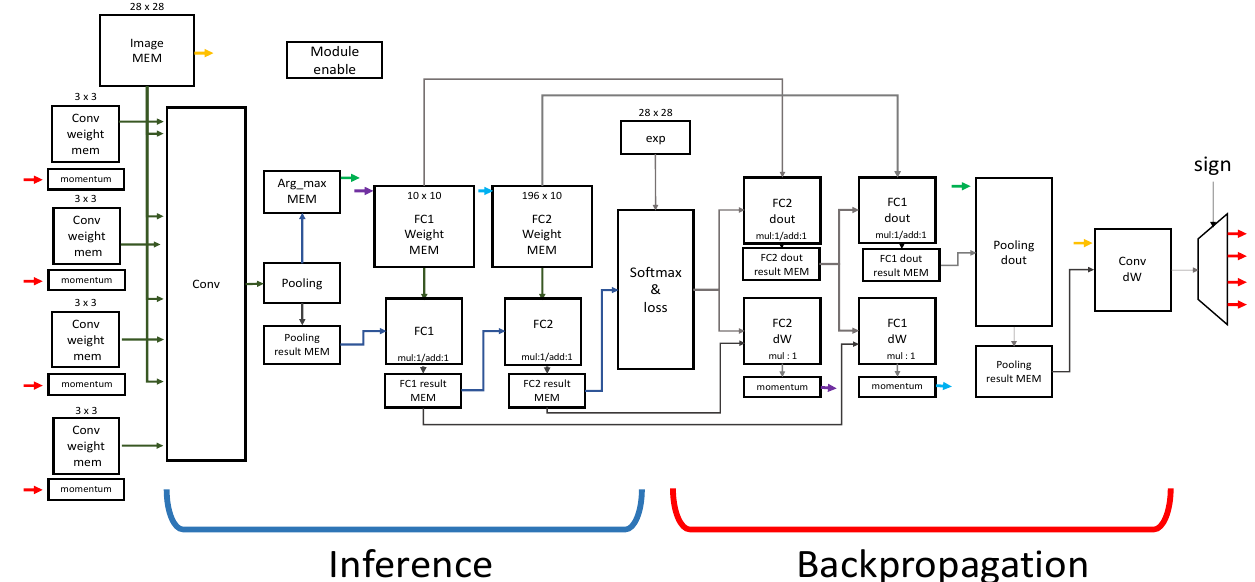
Figure 9. Architecture of inference and training hardware blocks. FC: fully-connected. (MEM: memory)